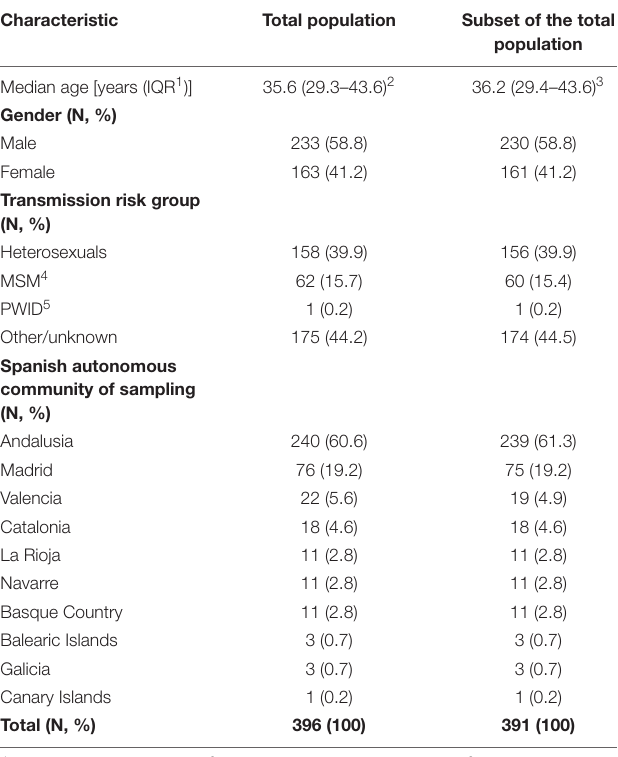
TABLE 1 | Characteristics of the study population: (i) total population ( N = 396), and (ii) a subset of the total population ( N = 391 of 396) after the exclusion of identical